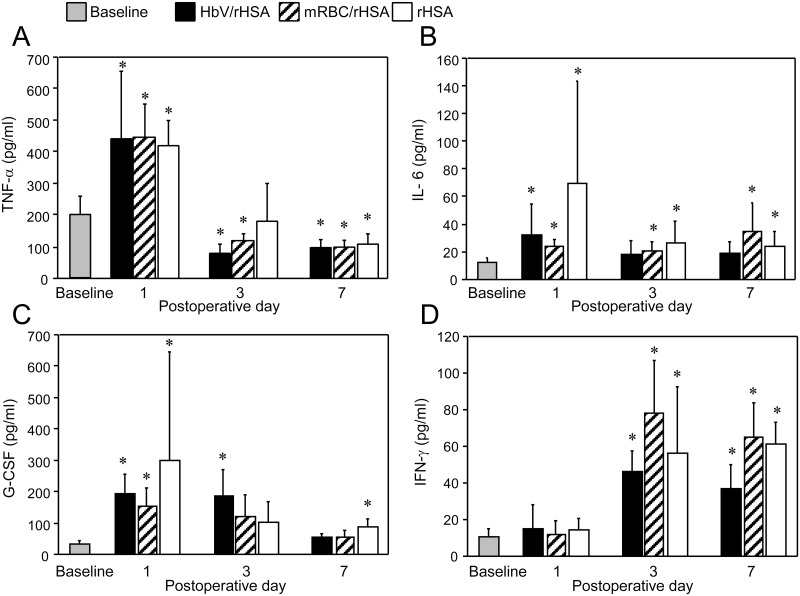
Changes in serum concentrations of (A) TNF-α, (B) IL-6, (C) G-CSF, and (D) IFN-γ between the baseline period and the 7th postoperative day (POD), in the indicated study groups.Values are shown as the mean ± SD. n = 10 in each group. *P < 0.05 versus baseline (Student’s t-test).